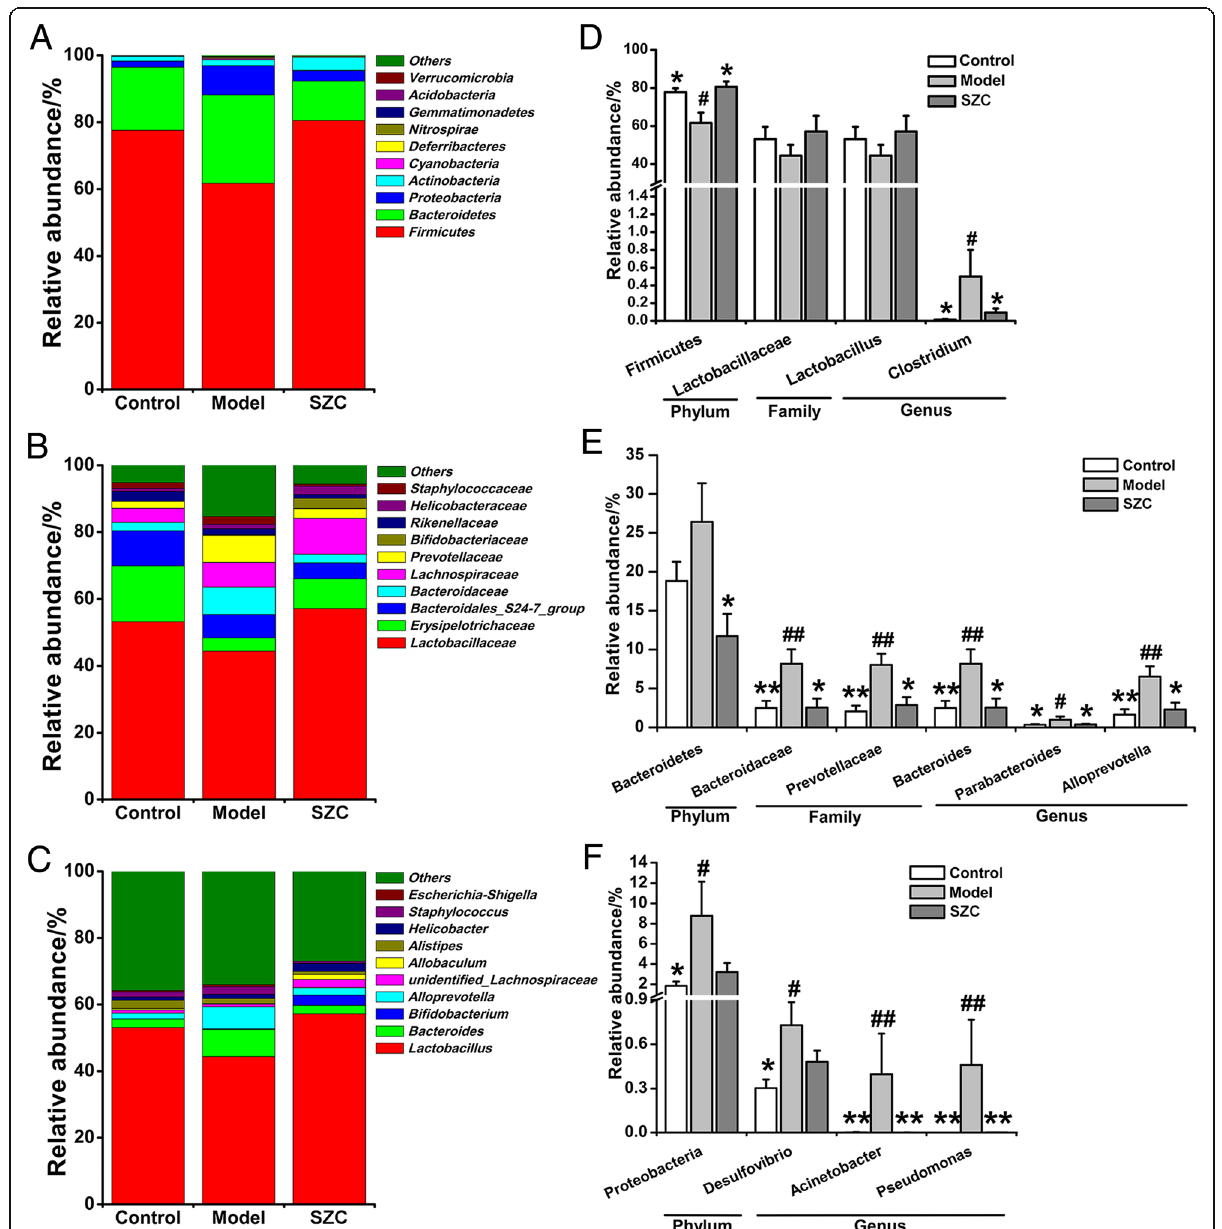
Fig. 6 The effects of SZC on the key phylotypes of gut microbiota in mice with CID (n = 5, male/femal = 2 – 3). ( a ) Relative abundance of different bacterial phyla. ( b ) Relative abundance of different bacterial families. ( c ) Relative abundance of different bacterial genera. ( d ) Relative abundances within Firmicutes . ( e ) Relative abundances within Bacteroidetes . ( f ) Relative abundances within Proteobacteria . Data were presented as means ± SEM. * P < 0.05 and ** P < 0.01 compared with model, # P < 0.05 and ## P < 0.01 compared with